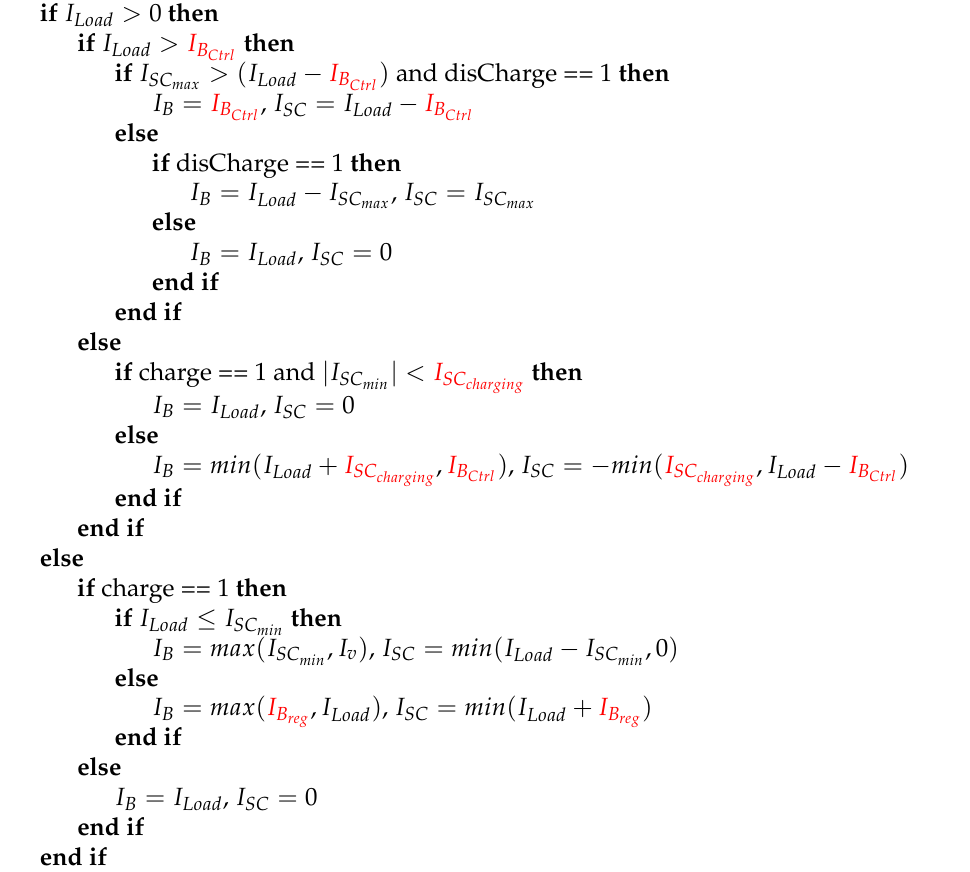
Algorithm 1 Rule-based distribution of the load current to the battery and